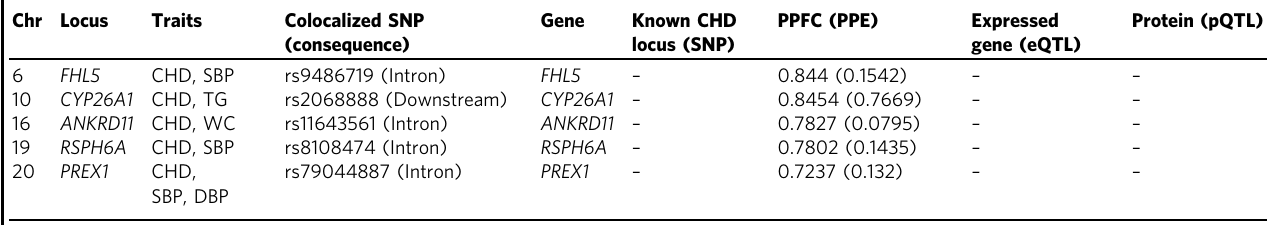
Table 3 New CHD loci sharing colocalized associations with related